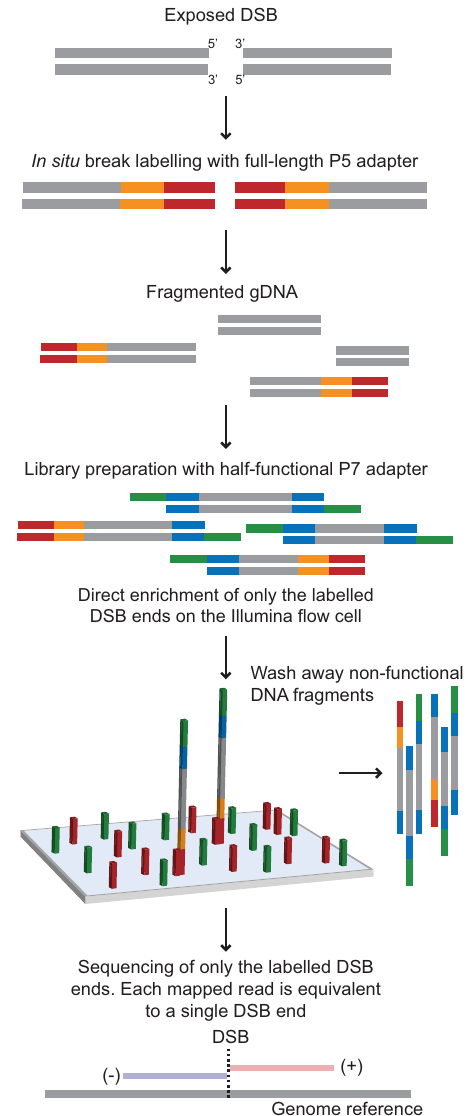
Fig. 1 The INDUCE-seq work fl ow. In situ break labelling in fi xed and permeabilised cells is performed by ligating a full-length, chemically modi fi ed P5 sequencing adapter to end-prepared DSBs. Genomic DNA is then extracted, fragmented, end-prepared and ligated using a chemically modi fi ed half-functional P7 adapter. Resulting DNA libraries contain a mixture of functional DSB-labelled fragments (P5:P7) and non-functional genomic DNA fragments (P7:P7). Subsequent illumina sequencing of INDUCE-seq libraries enriches for DNA-labelled fragments and eliminates all other non-functional DNA. As the INDUCE-seq library preparation is PCR-free, each sequencing read obtained is equivalent to a single